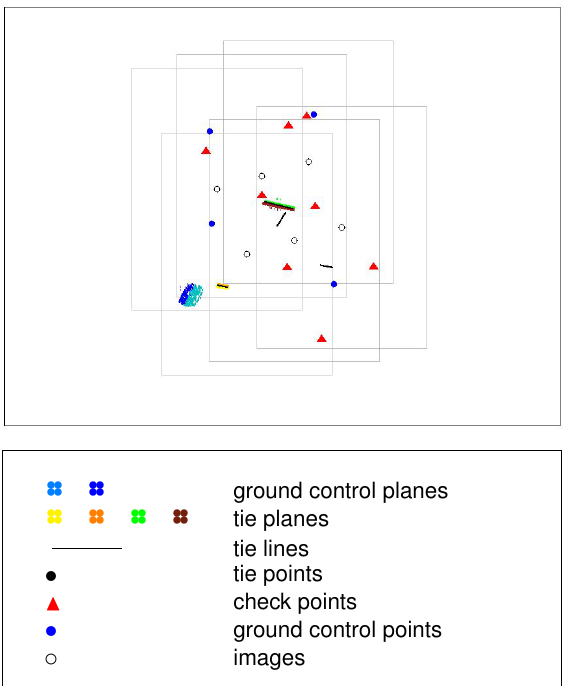
Figure 2: Castellbisbal block layout.